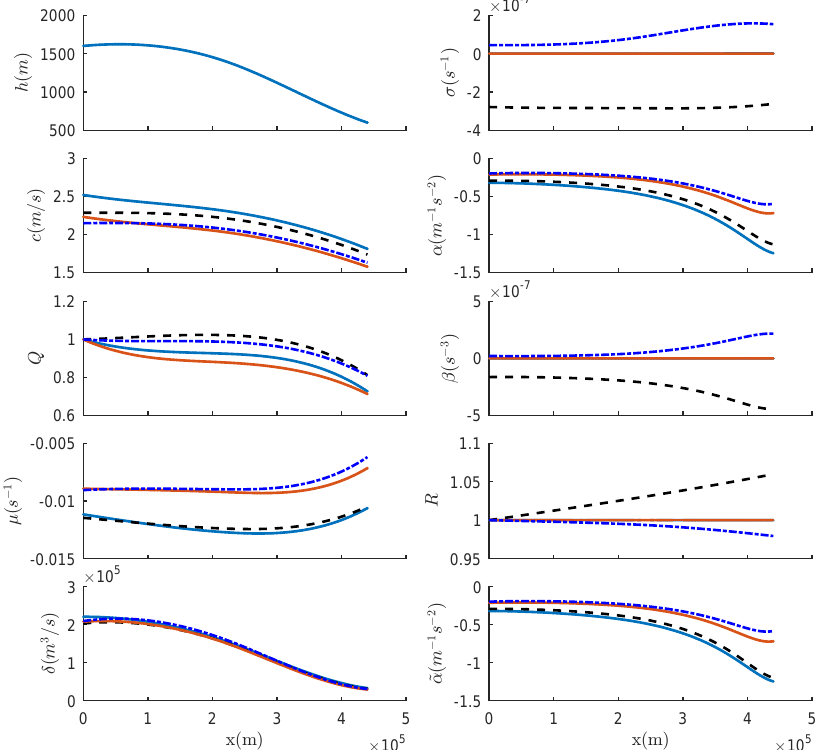
Figure 6. Variation of the original coefficients (left panel and top of the right panel) and the derived coefficients (remainder of the right panel) of the vKdV equation for conditions of the South China Sea case. The results show the coefficients in summer with background current u 0 (blue, solid), without u 0 (black, dash) and the coefficients in winter with u 0 (red, solid), without u 0 (blue,